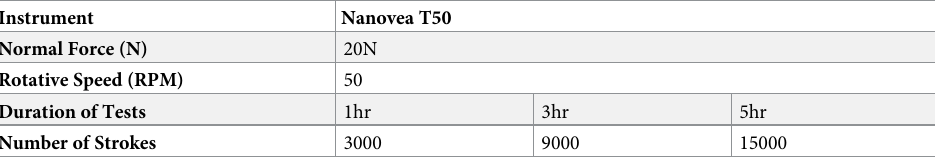
Table 1. Input parameter used for the tribological experiment with the archaeological